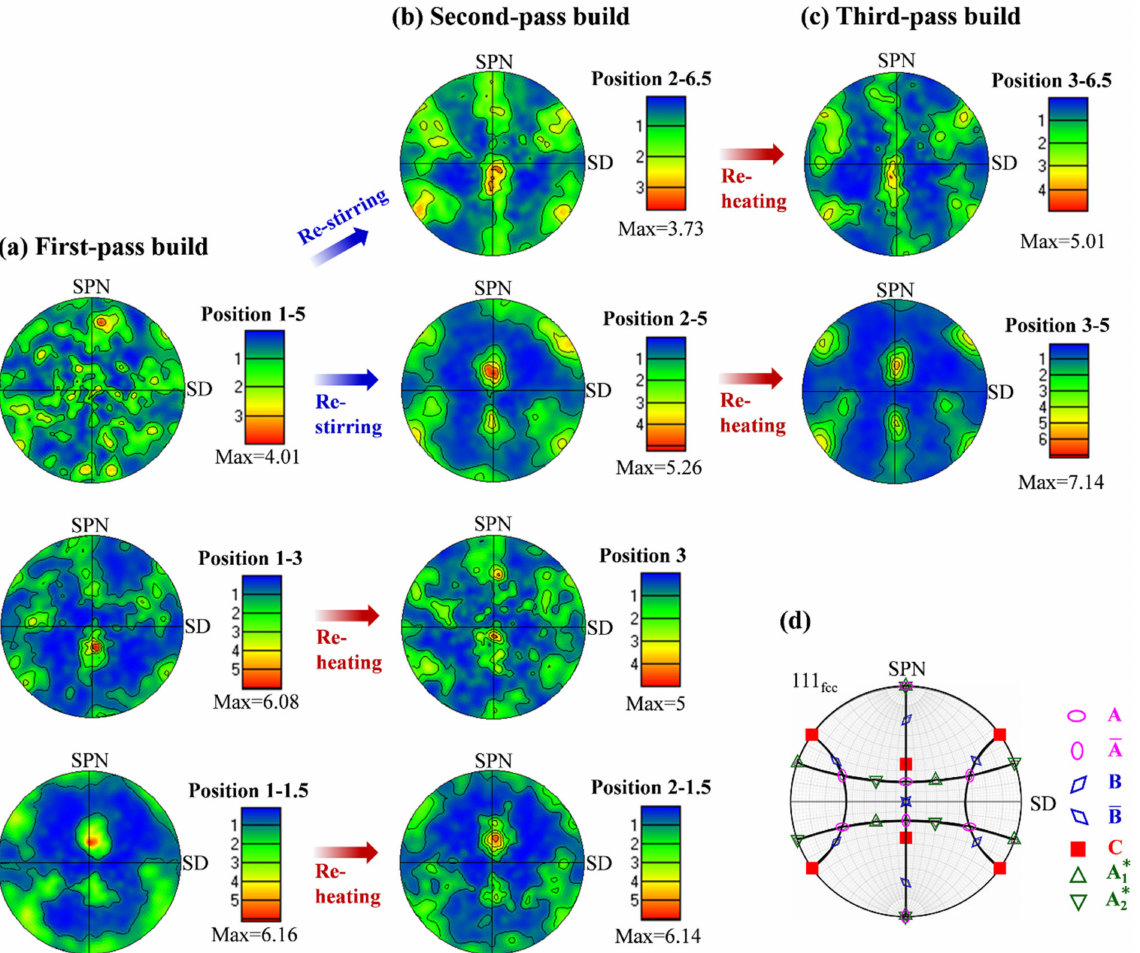
Figure 6. {111} Pole figures (PFs) in different regions of the ( a ) first-, ( b ) second-, and ( c ) third-pass builds; ( d ) ideal orientations of face-centered cubic metals under simple shear [46,47]. The specified positions of the PFs are shown in Figure 3a–c, marked with red dots. From the abovementioned STEM observation and the microstructures in various re- gions of the builds, the grain size is a key factor that affects the number of grain boundary Mg(ZnAlCu) 2 particles. The smaller the grain is, the more Mg(ZnAlCu) 2 particles precipi- tate along the grain boundary. During underwater FSAM, restirring significantly refined the grain size in the overlapping region of the build and promoted the precipitation of Mg(ZnAlCu) 2 particles along the grain boundaries. These grain boundary Mg(ZnAlCu) 2 particles could prevent grain growth by pinning the grain boundaries and subgrain bound- aries. Additionally, these precipitates also suppressed the DRX process through hindering dislocation movement. The abovementioned phenomena were more obvious in the bottom of the overlapping region. However, the reheating effects on dissolution, reprecipitation, and growth of the Mg(ZnAlCu) 2 phase were not obvious owing to water